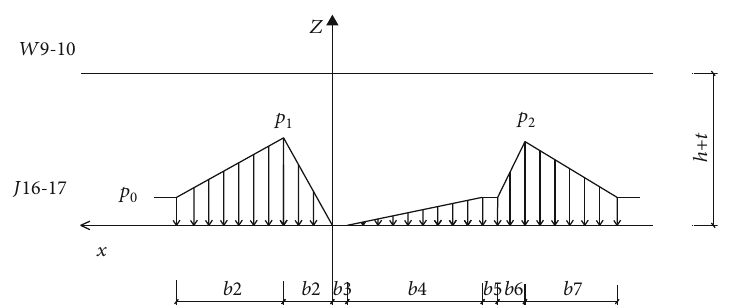
Figure 5: Distribution diagram of roof stress after mining in J coal